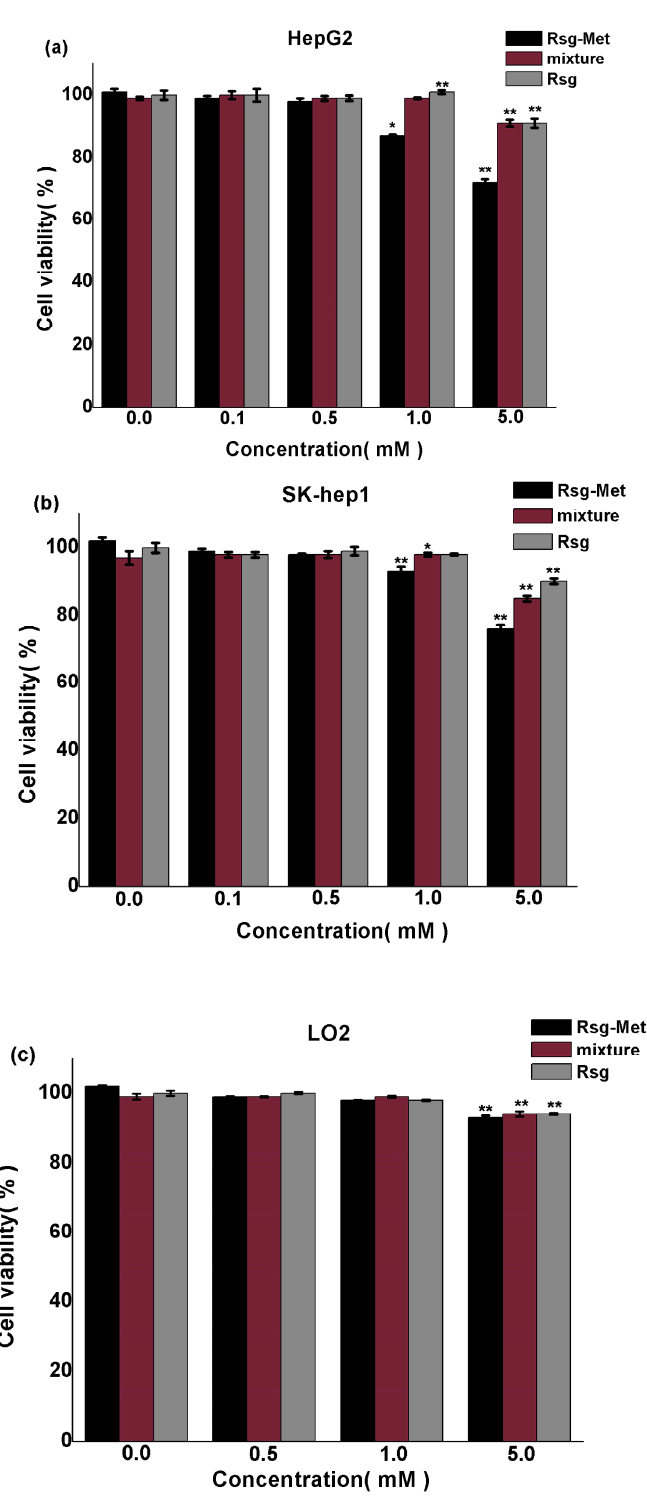
Figure 6. Dissolution rate of Rsg and Rsg -Met in alkaline medium (pH = 6.8). Notably, Met powder was directly soluble when it contact with an alkaline medium (pH = 6.8) [21,22], so it was impossible to acquire any dissolution rate data, hence there are no Met results in this test and we concluded that the Met was an extremely soluble compound. In this context, the trend depicting the dissolution rates of these samples was as follows: Met > Rsg-Met > Rsg. 2.3. The Cytotoxicity on Liver Cancer Cells The results of the MTT assay are shown in Figure 7 and the cytotoxicity ranking was the Rsg-Met > Rsg and Met mixture > Rsg. It was found that Rsg-Met inhibited proliferation of two human hepatoma cell lines (HepG2 and SK-hep1) in a dose-dependent manner. The mixture and Rsg also caused a dose-dependent inhibition in liver cancer cells, however, a significant reduction of proliferation was found in the presence of the Rsg-Met at 1 mM, but not with the other two agents (Figures 7 (a,b)). It was suggested that Rsg-Met was not acting as a simple sum of the two